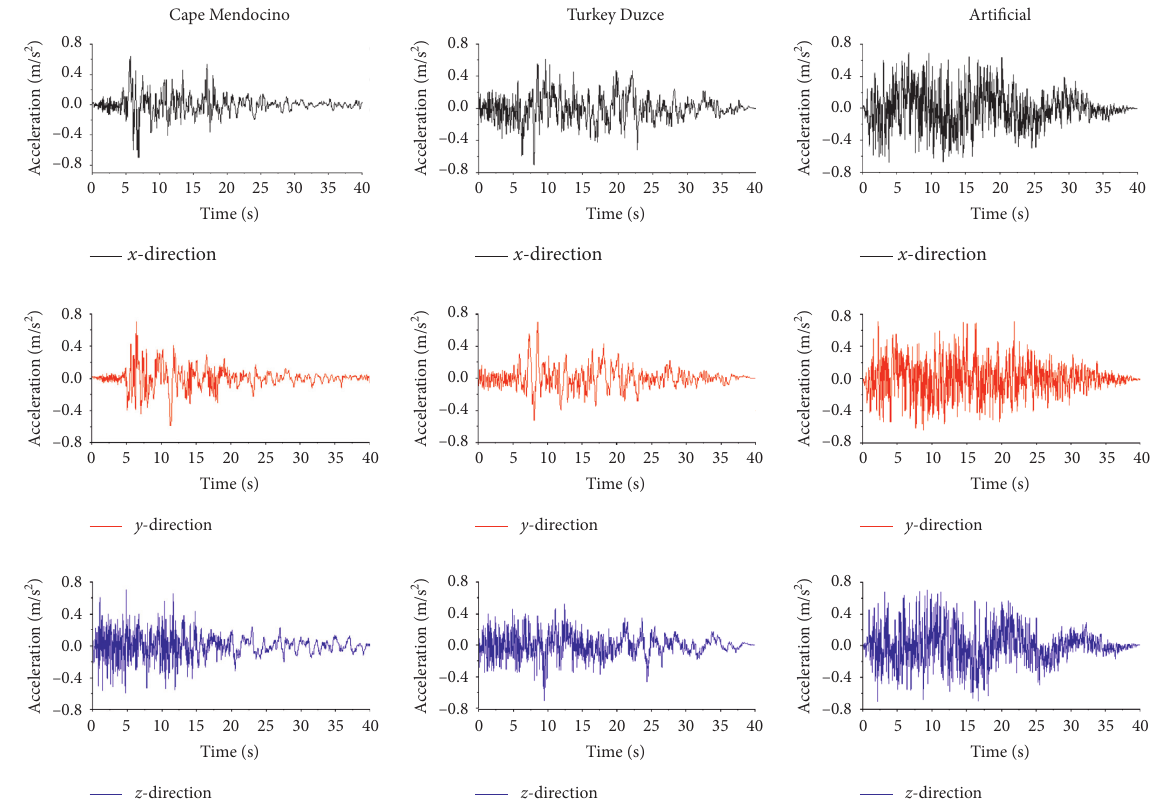
Figure 8: Acceleration time history of Cape Mendocino and Turkey Duzce and artificial seismic record.